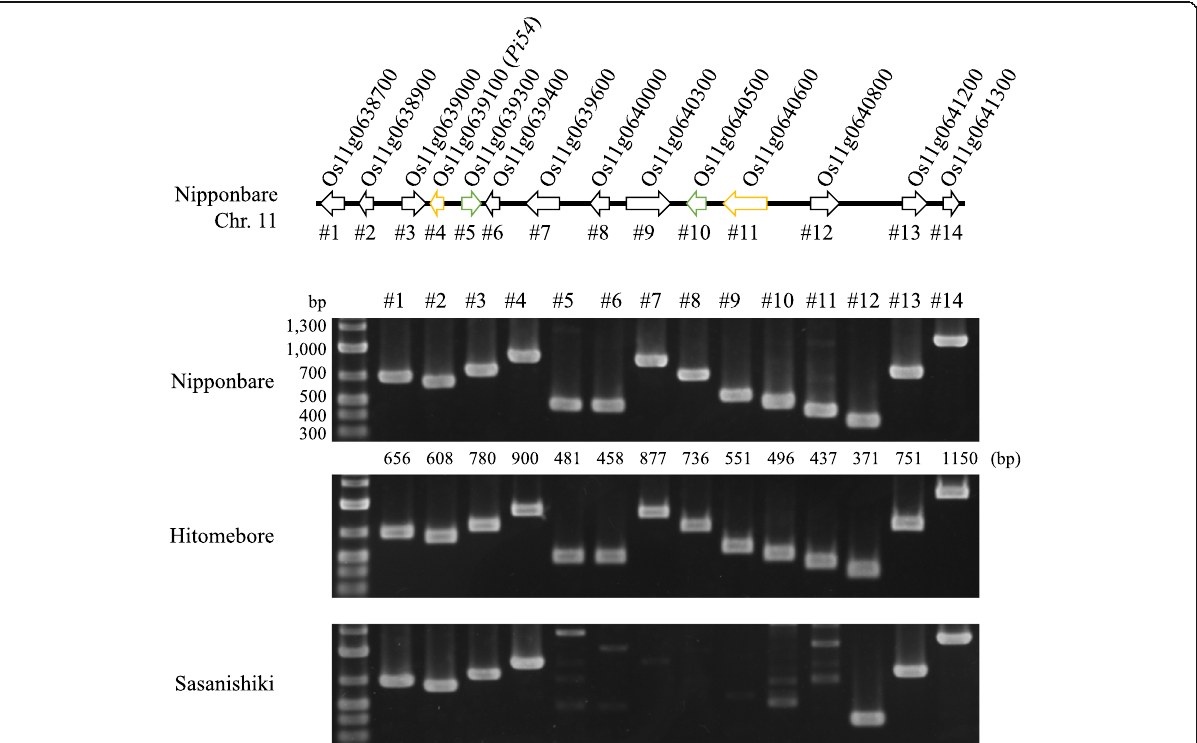
Fig. 1 PCR analysis of 14 genes (Os11g0638700 – Os11g0641300) in Nipponbare, Hitomebore and Sasanishiki. Marker fragment sizes are shown on the left PCR product sizes are shown at the bottom of the Nipponbare pane